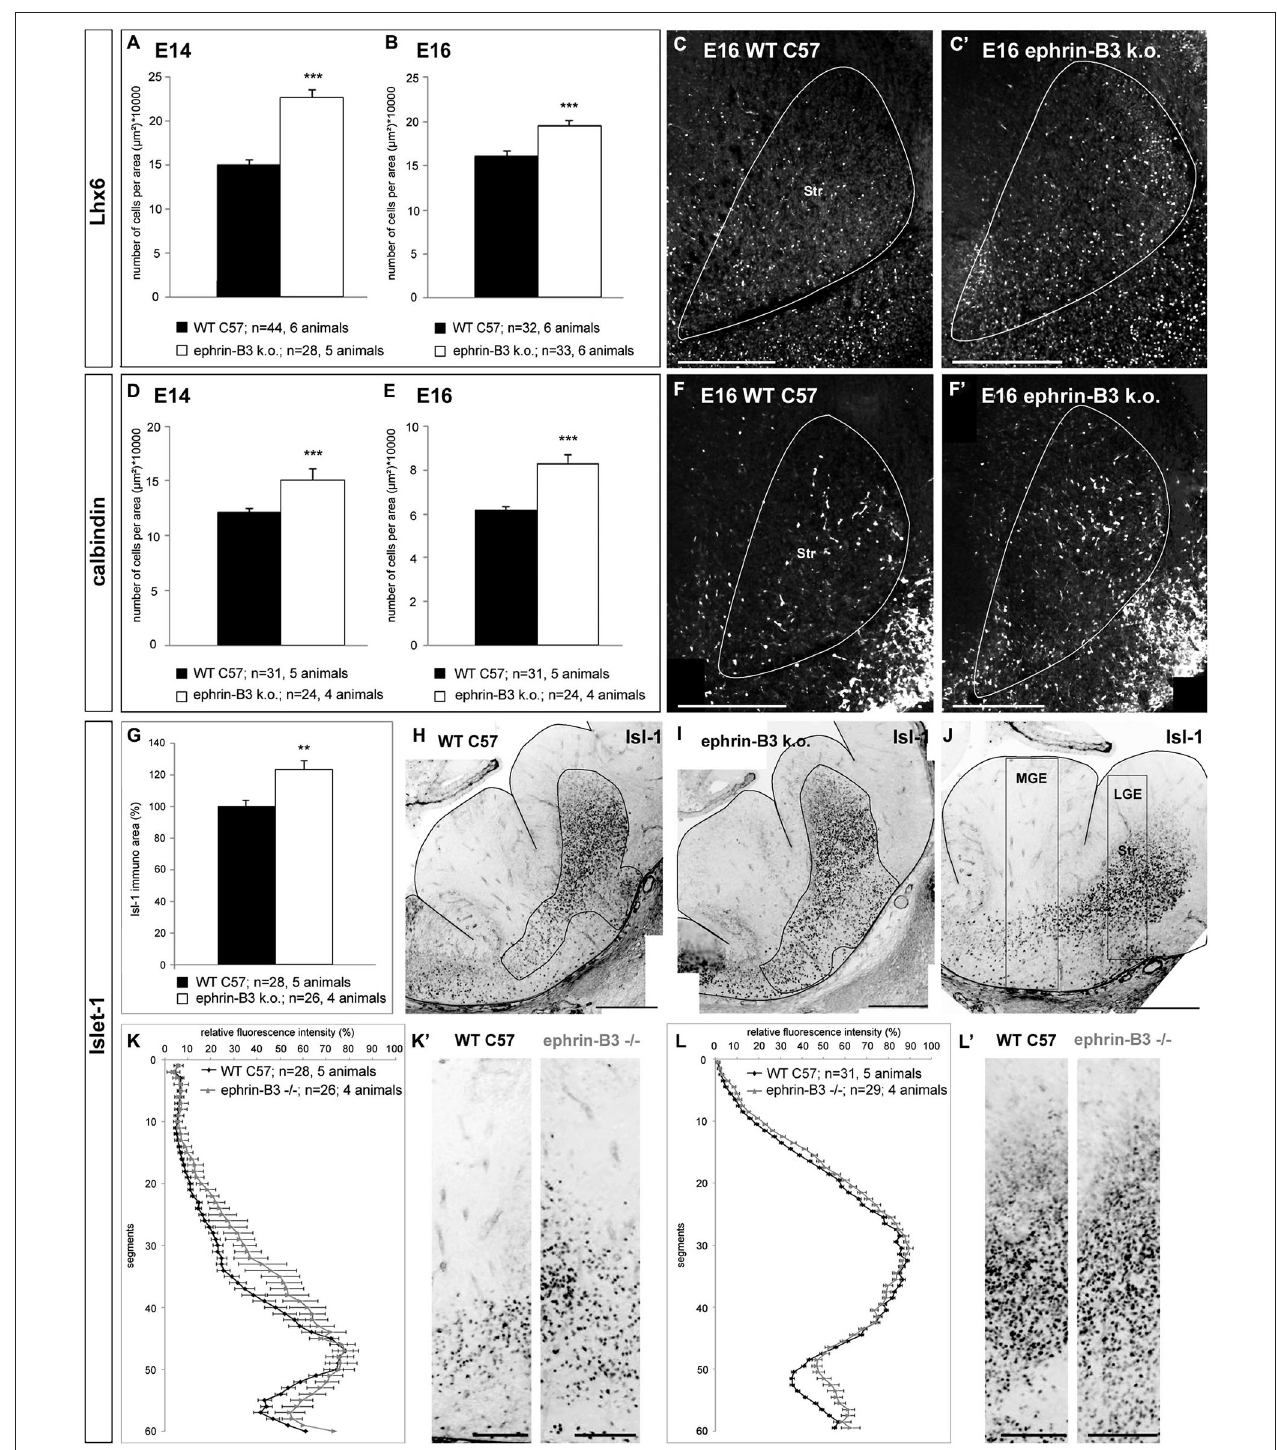
the striatal region of a coronally sectioned hemisphere at E16. The white area marks the striatum. There are more Lhx6 stained neurons in the striatum of ephrin-B3 mutant embryos ( C’ ) than in the wild type ( C